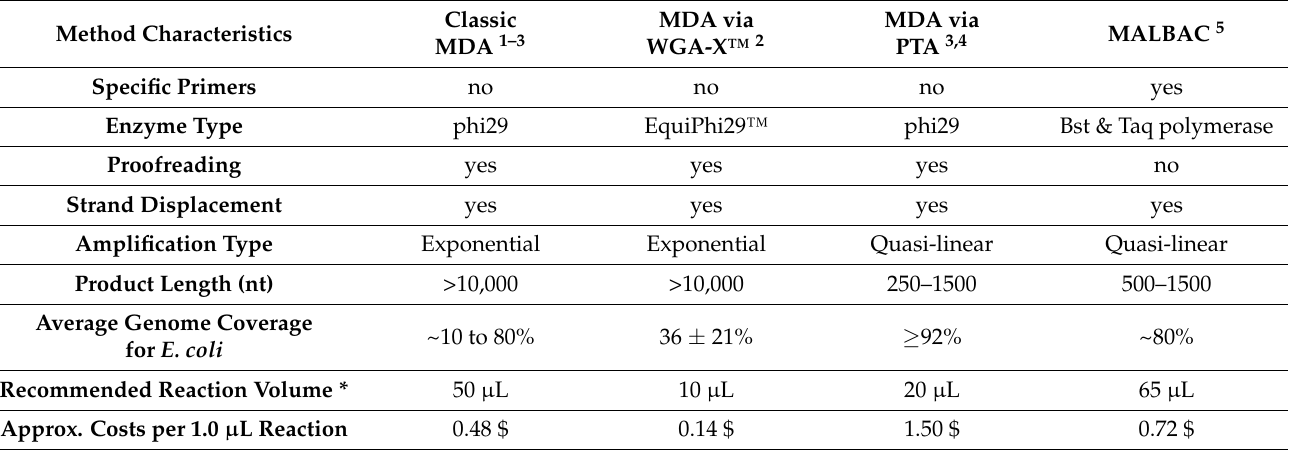
Table 1. Method characteristics of microbial single-cell genome amplification methods. MDA, multi- ple displacement amplification; WGA-X, whole genome amplification—X; PTA, primary template- directed amplification; MALBAC, multiple annealing and looping based amplification